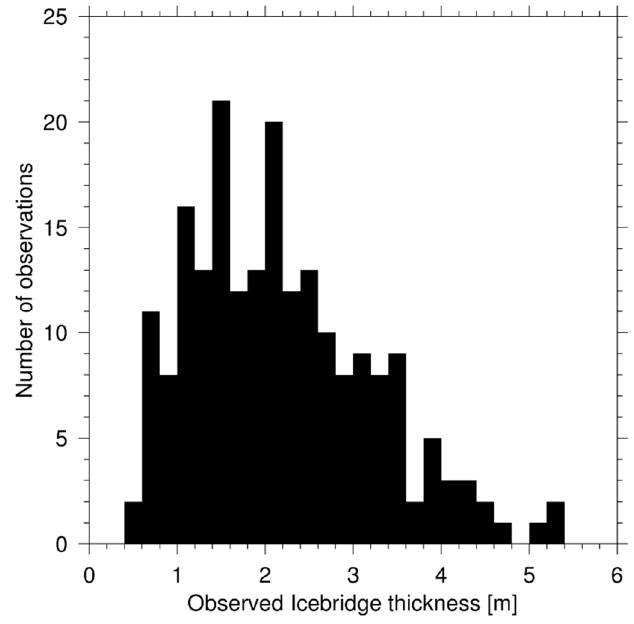
Figure 1. IceBridge ice thickness data points for one ice age parcel.